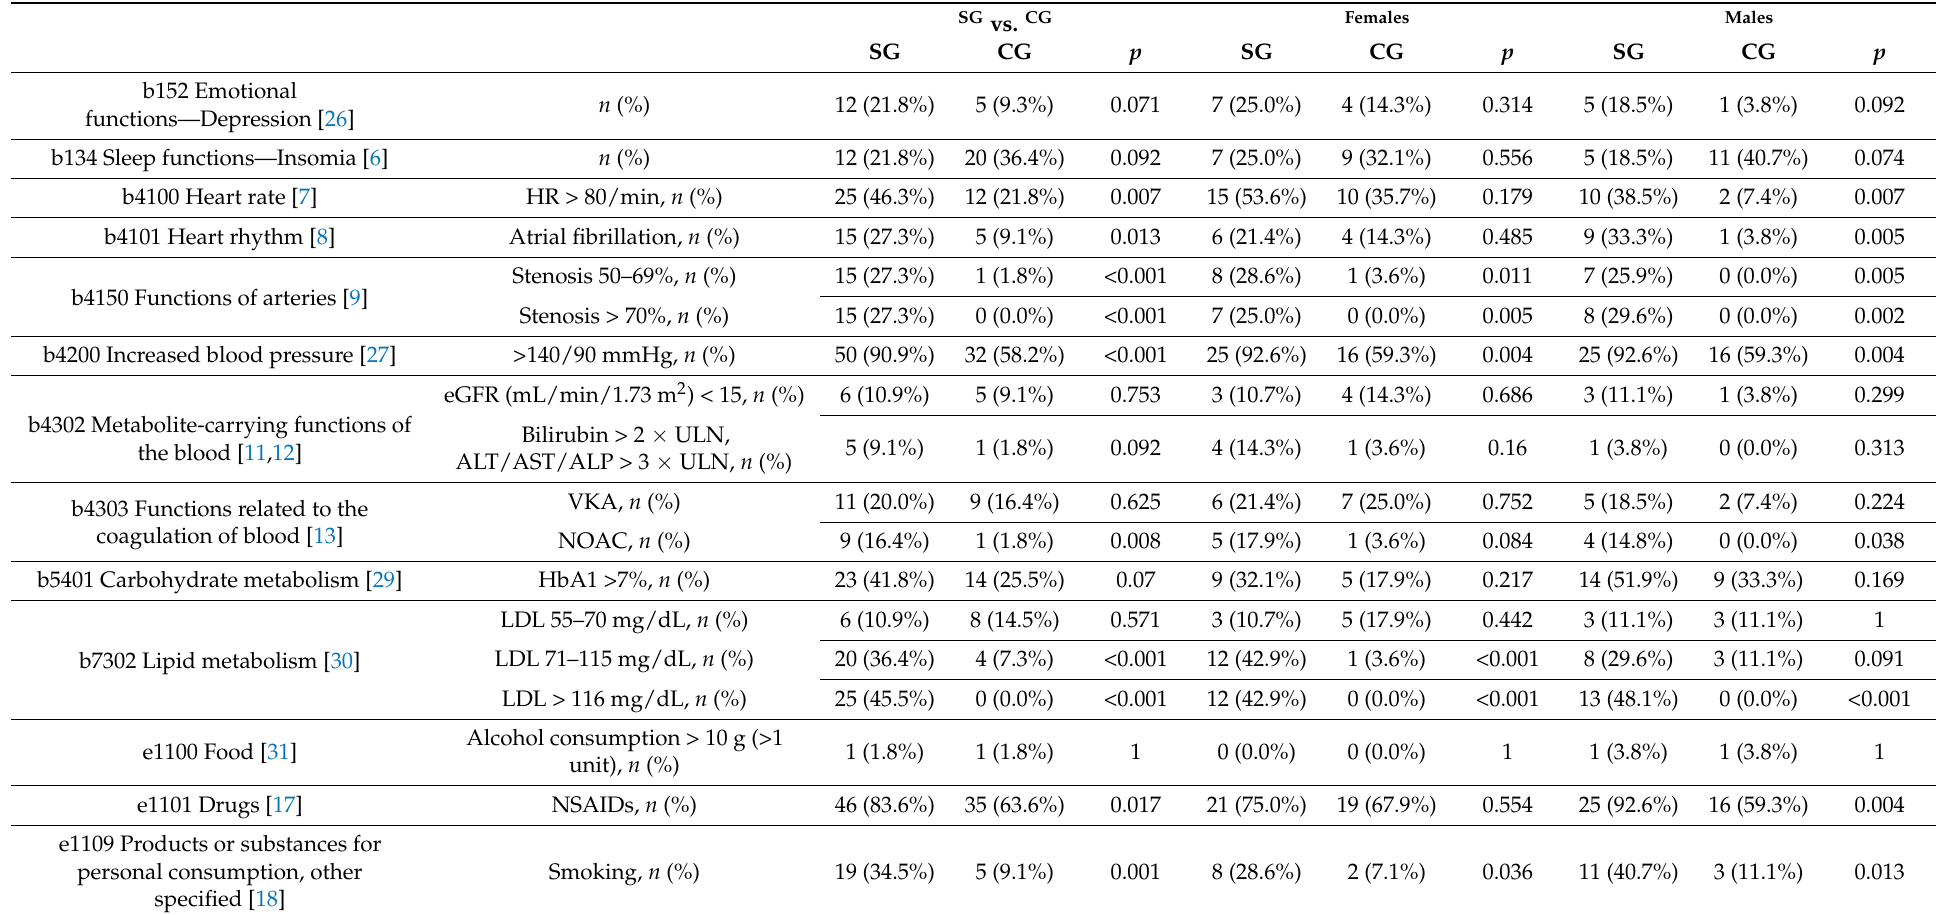
Table 2. Differences in the incidence of CVD risk factors depend on the history of non-ischemic stroke and